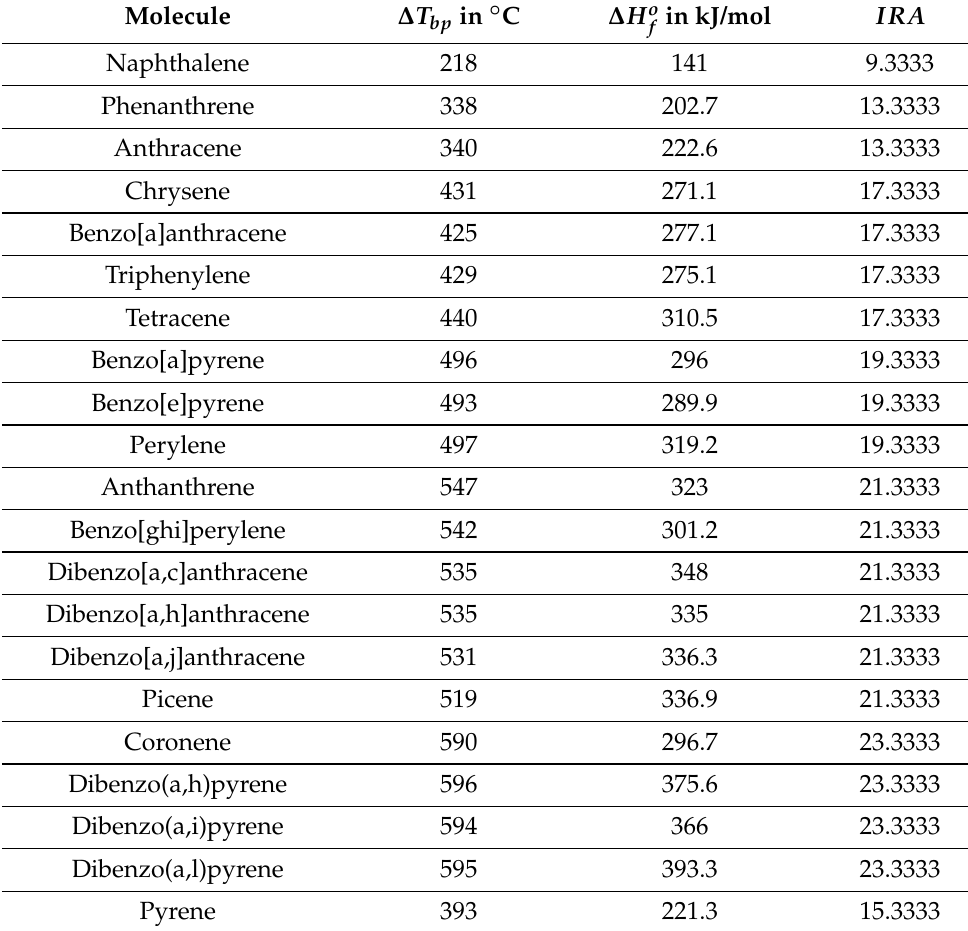
and the IRA index of the 22 lower PAHs. f